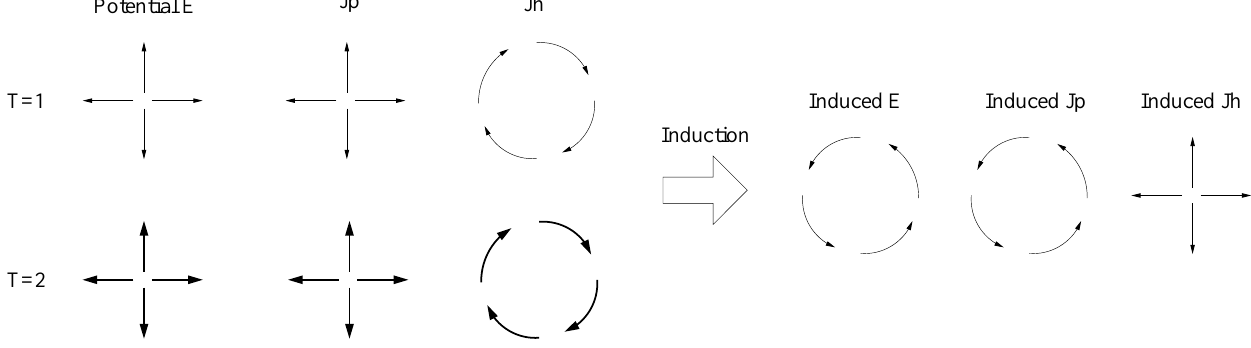
Fig. 1. Lenz’s law in the northern auroral ionosphere (with uniform conductances and downward pointing background magnetic field). Changes of the potential electric field ( E pot ) and associated currents (Jp and Jh) create rotational induced electric field ( E ind ). Induced currents oppose the change in rotational currents, but enhance the change in divergent currents (i.e. FAC).